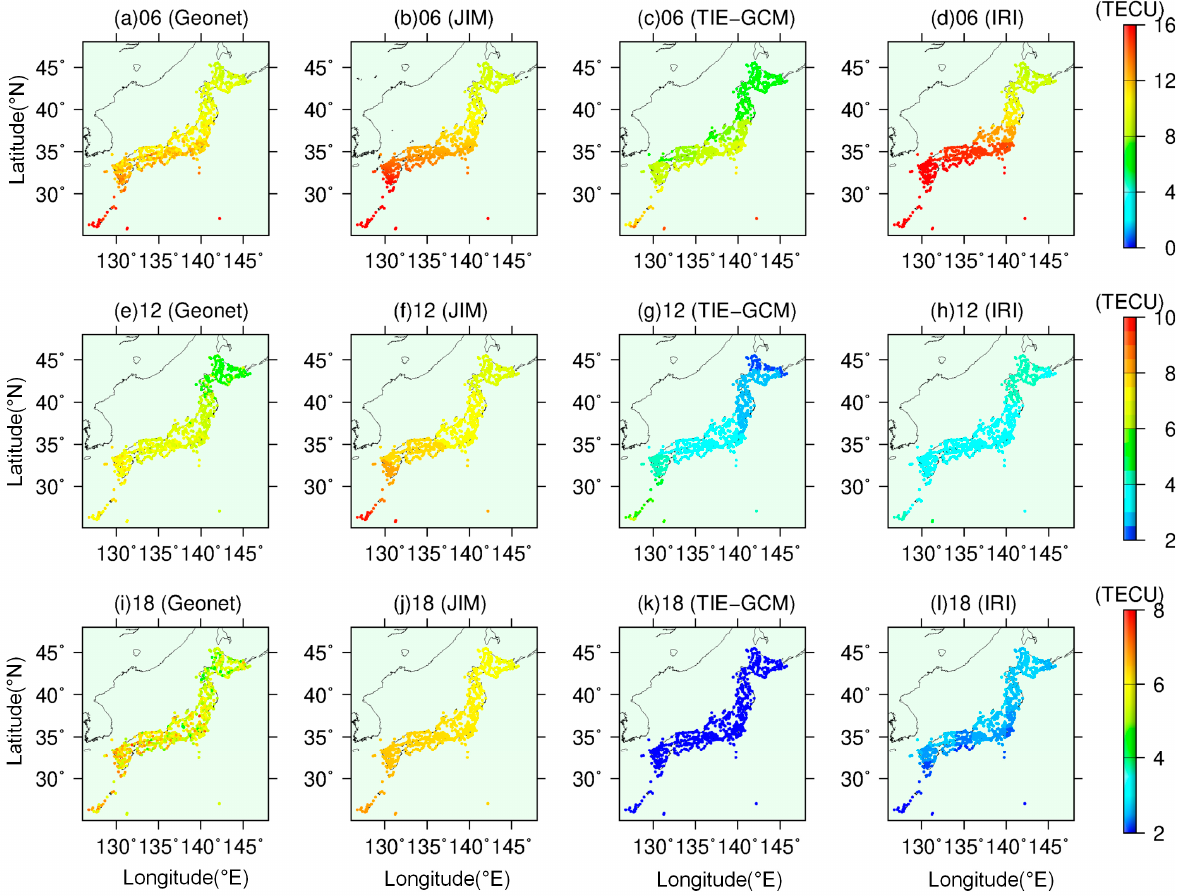
Figure 8. TEC maps derived from the GEONET observations. JIM, TIE-GCM and IRI-2016 model at UT06, UT12 and UT18 on 22 March, 2020 when the solar wind speed was lower than 470 km/s and the Dst was larger than − 20 nT.